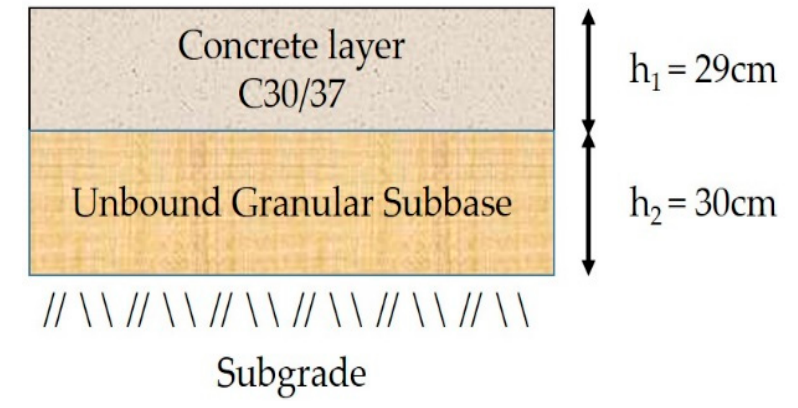
Figure 5. Cross-section of the pavement under